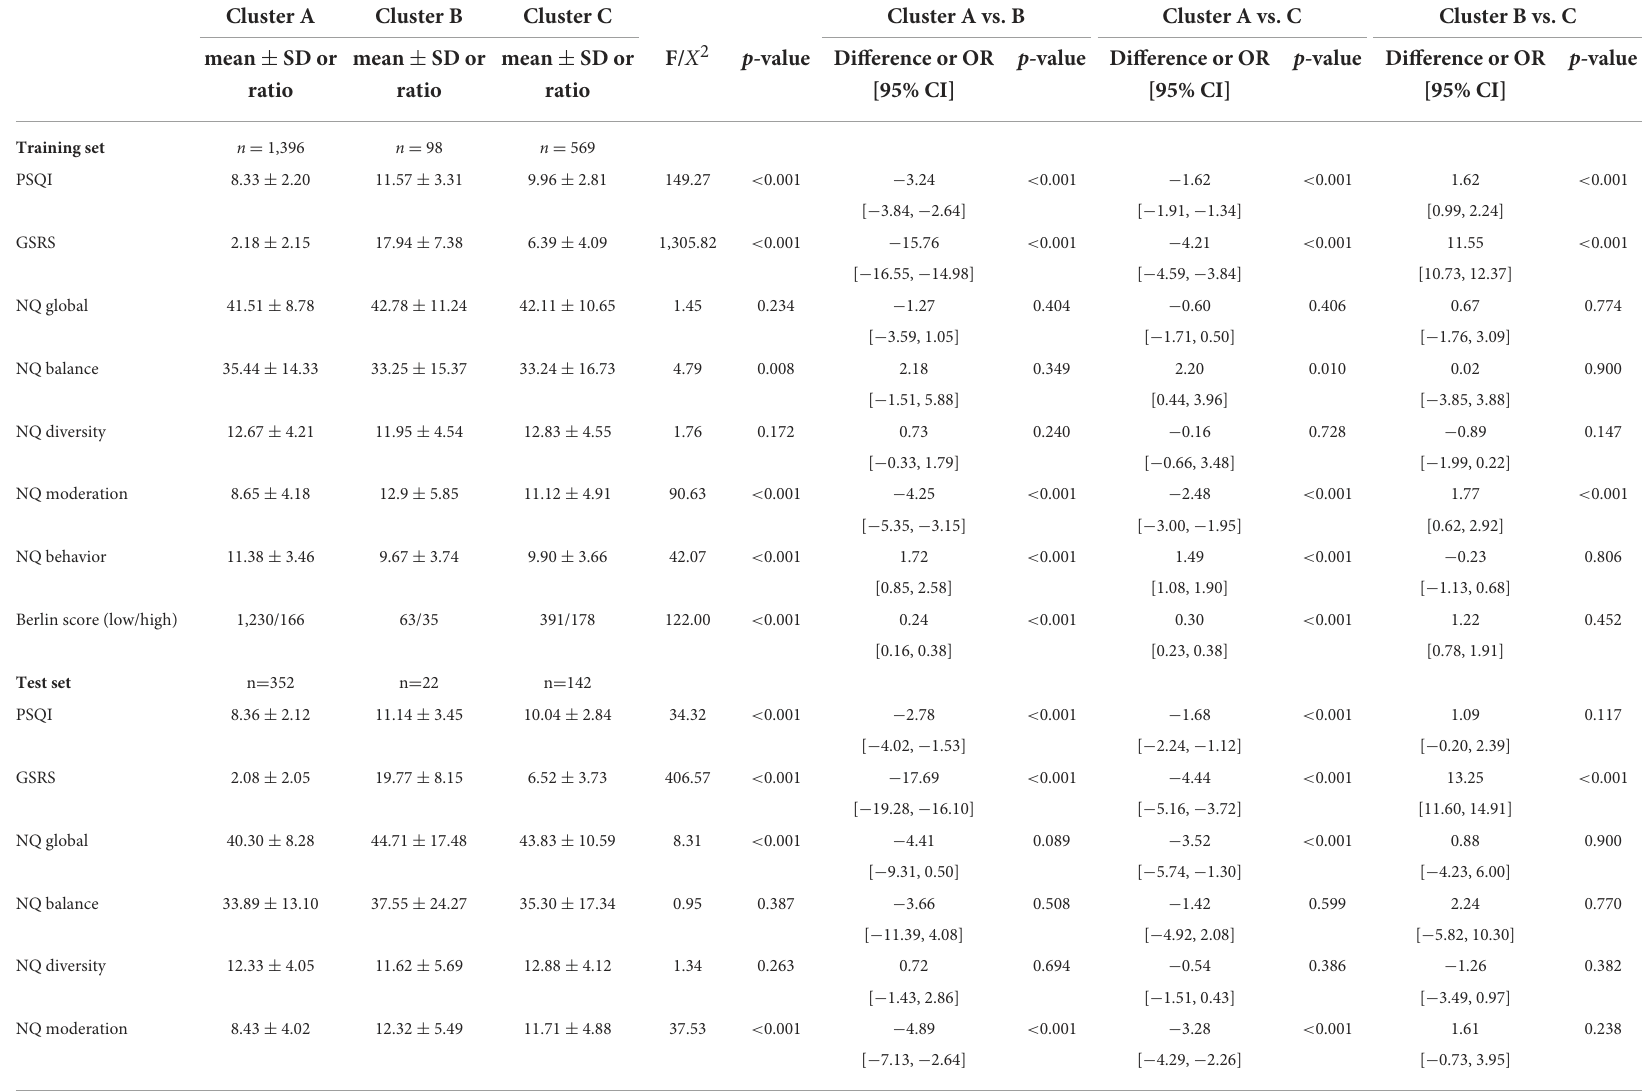
TABLE 4 Results of external cluster validation in the training set and test